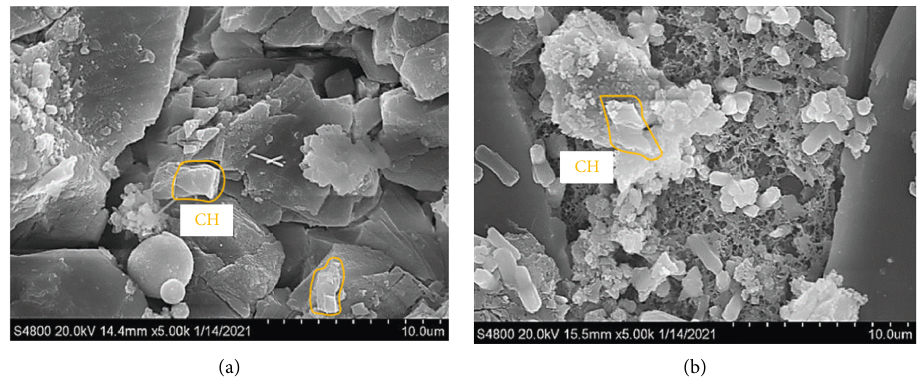
Figure 16: Micromorphology of internal pores of S-100-0.200%: (a) 28d; (b) 56d.